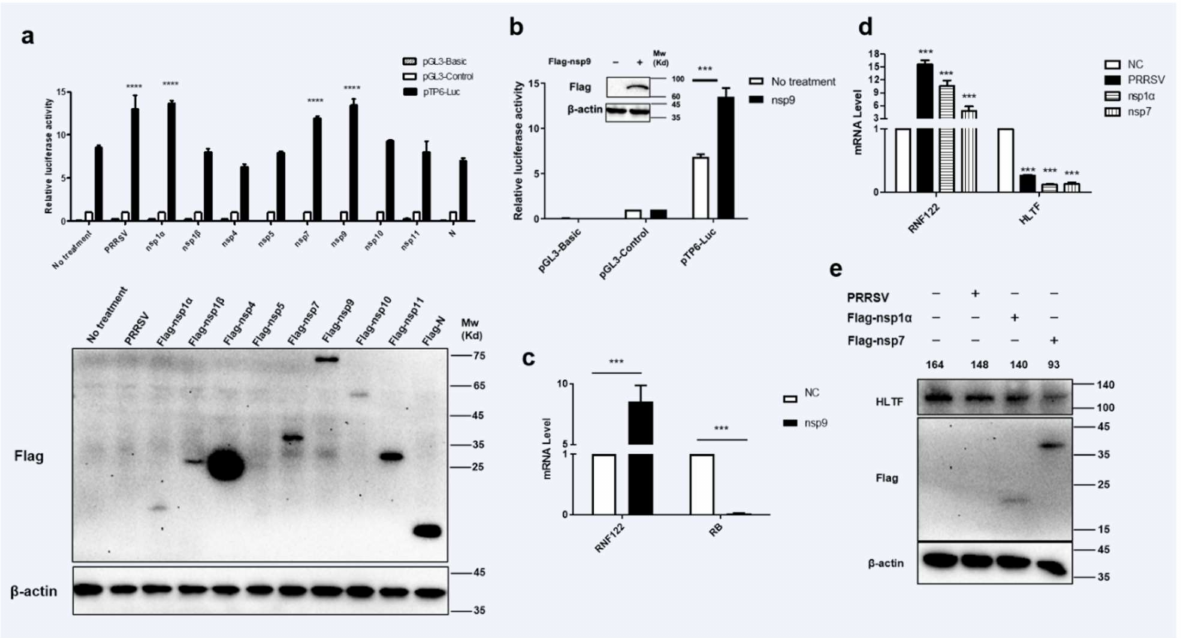
Figure 4. Transcriptional regulations of RNF122 were mediated by PRRSV nsp1 α , nsp7 and nsp9. ( a ) HEK293T cells were co-transfected with pTP6-Luc and pRL-TK, and then transfected nsp1 α , nsp1 β , nsp4, nsp5, nsp7, nsp9, nsp10, nsp11, N plasmids, respectively, or infected with